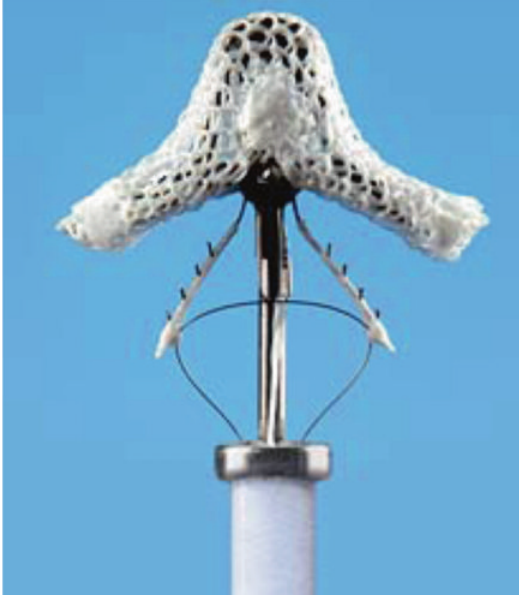
Percutaneous mitral clip device (Mitra- Clip ® System) introduced by venous and transseptal approach into the left atrium and through the mitral orifice. The arms of the clip delivery system are open to grasp the two leaflets following positioning of the device centered over the origin of the regurgitant jet (fig.